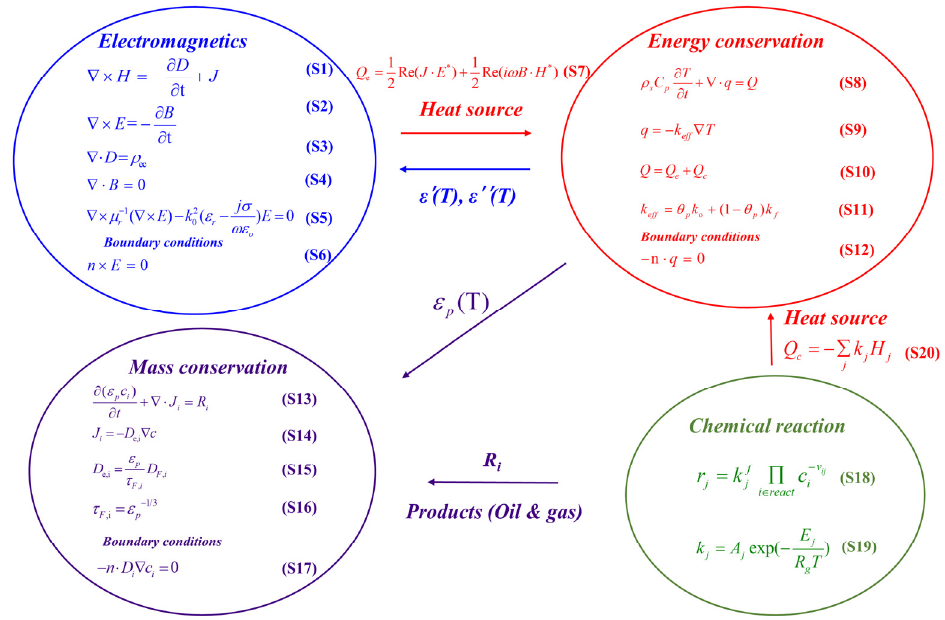
Figure 1. Mathematical equations and their corresponding